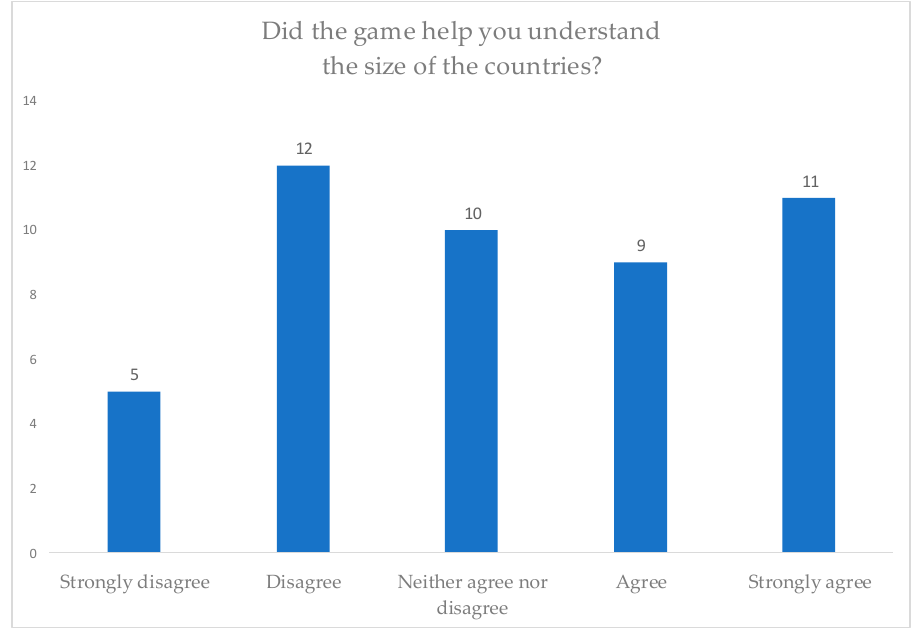
Monopoly/Geopoly).